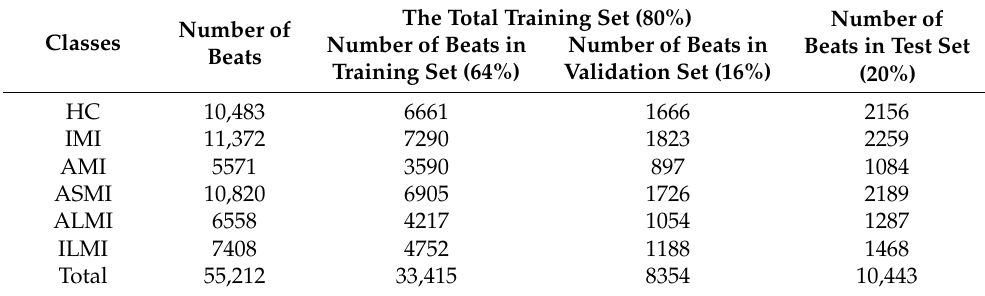
Table 4. Dataset distribution.